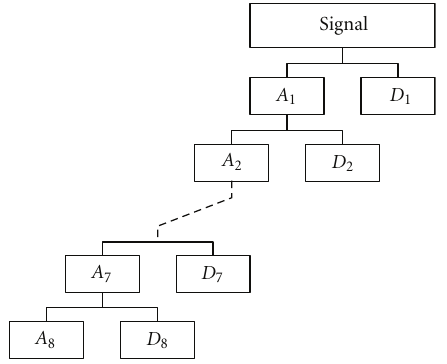
Figure 3: The DWT decomposition showing the various approx- imation and detail signals at eight levels. The original vibration signal is decomposed into a low-frequency component ( A 1 ) and a high-frequency component ( D 1 ). Each successive approximation is then decomposed into an approximation and a detail component, for example, A 1 = A 2 + D 2 , A 2 = A 3 + D 3 , and so